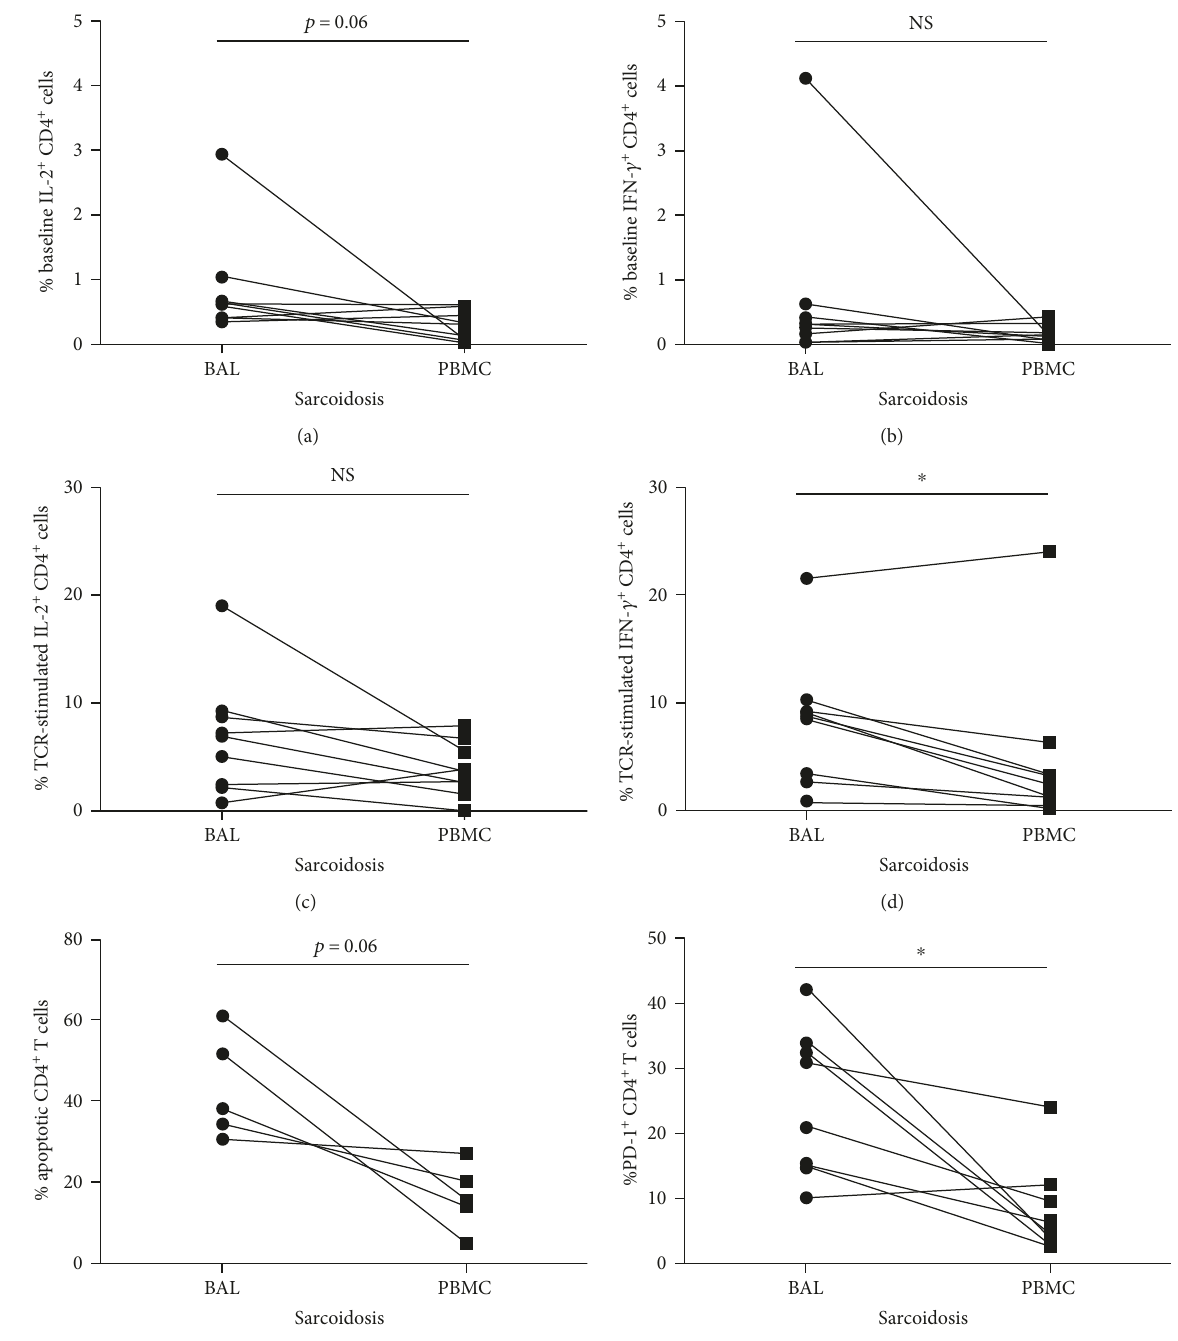
Figure 6: Immune dysfunction in sarcoidosis BAL versus PBMC. BAL cells and matching PBMC isolated from sarcoidosis subjects were analyzed according to immune parameters associated with T cell exhaustion. (a, b, c, and d) Intracellular staining for cytokine production: cells were incubated in the absence (a and b) or presence (c and d) of TCR stimulation for 6 hours with Golgi Stop. Cells were then stained with anti-CD3, anti-CD4, and anti-CD8 before permeabilization and staining with PE-conjugated anti-IL-2. Flow cytometry was conducted and live, singlet cells were gated to assess the percentage of CD4 + CD3 + cells that had produced IL-2 or IFN- γ . Unstimulated cells (baseline) were used to help determine the IL-2 production in TCR-stimulated cells. (a and b) Baseline IL-2 and IFN- γ production. (c and d) TCR-stimulated IL-2 and IFN- γ production. (e) The percentage of apoptosing CD4 + T cells in matching BAL and PBMC was assessed using 7AAD and Annexin V staining. (f) PD-1 expression in the population of CD4 + T cells was determined in matching BAL and PBMC. Statistical analysis was performed using the Wilcoxon matched-pairs signed-rank test. ∗ p < 0 05 . NS: not signi fi